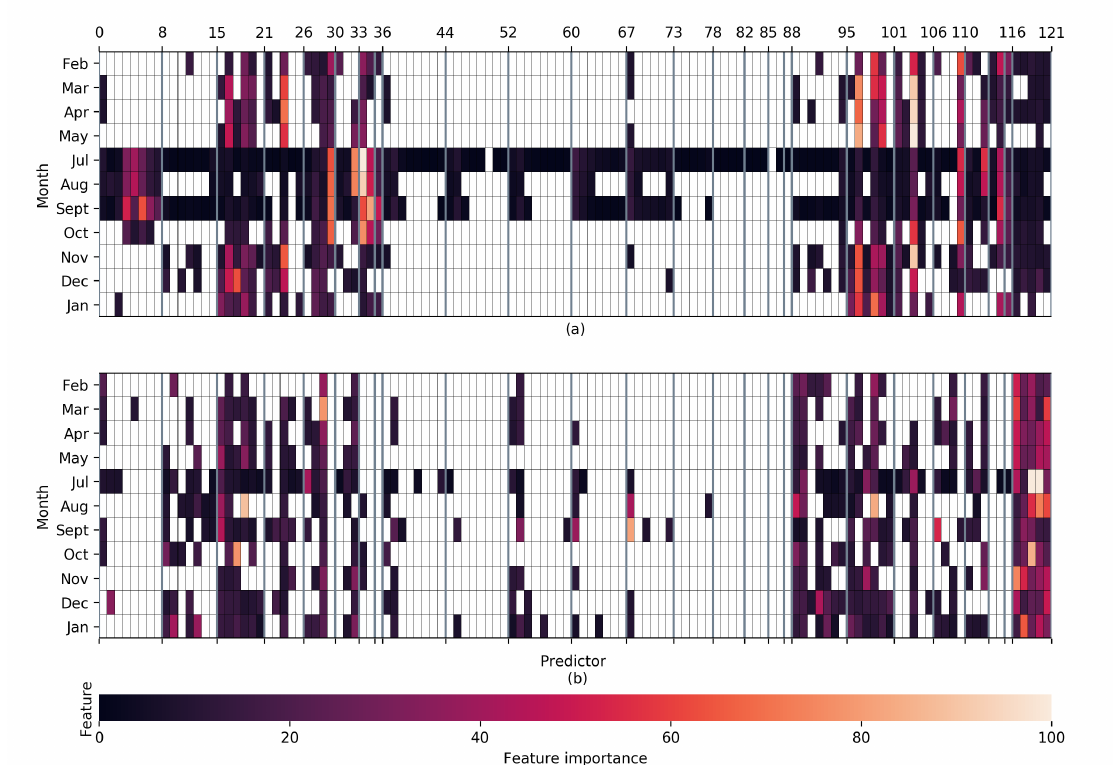
Figure 4. Selected predictors and related feature importance for the time period. ( a ) RF classification, ( b ) RF regression. Numbers on the x -axis represent feature IDs (refer to Appendix A for the legend and list of